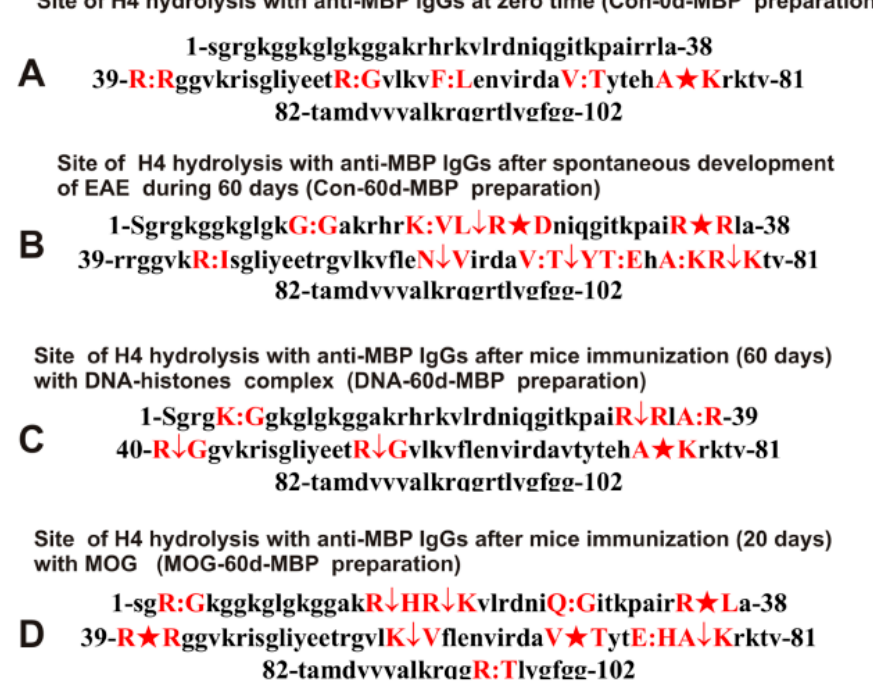
Figure 7. Sites of H4 hydrolysis by IgGs against MBP corresponding to different IgG preparations. Major sites of H4 cleavage are shown by stars ( ★ ), moderate ones by arrows ( ↓ ), and minor sites of the cleavages by colons (:) ( A – D ).